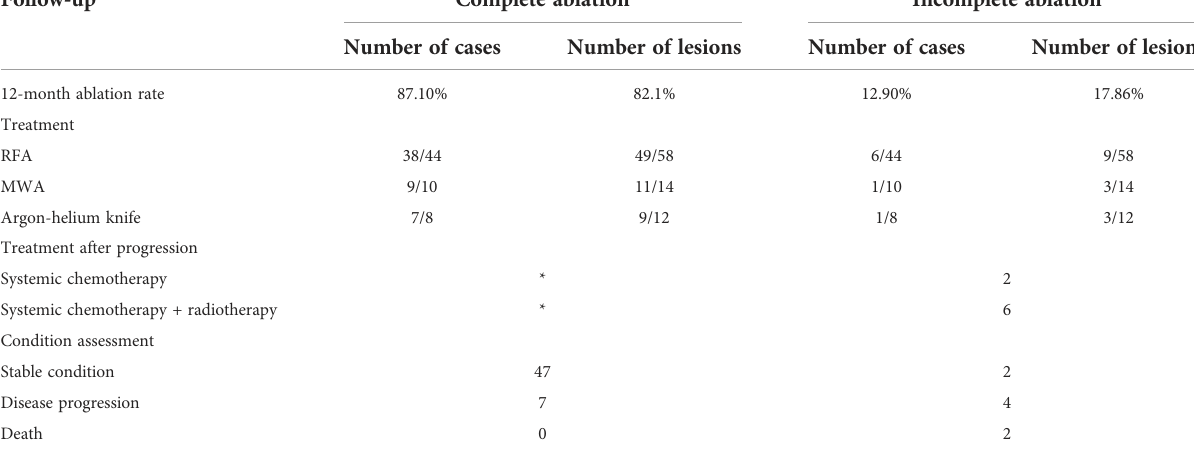
TABLE 2 12-month complete ablation rates and